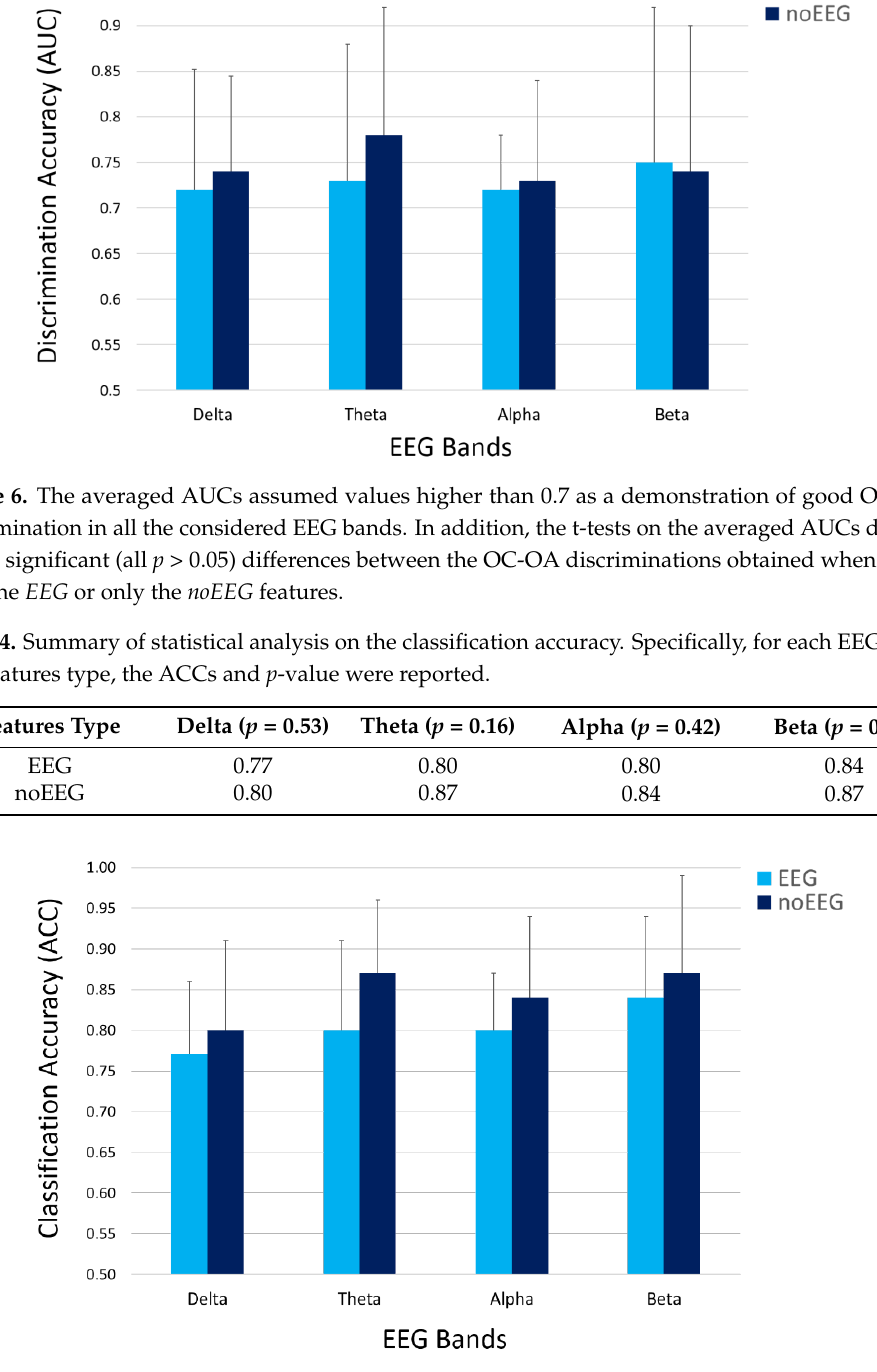
Figure 7. The averaged classification accuracies (ACCs) assumed values higher than 0.8 as a demonstration of high OA-OC classification in all the considered EEG bands. In addition, the t-tests on the averaged ACCs did not report significant (all p > 0.05) differences between the OC-OA classification obtained when using only the EEG or only the noEEG features. Table 4. Summary of statistical analysis on the classification accuracy. Specifically, for each EEG band and features type, the ACCs and p-value were reported.